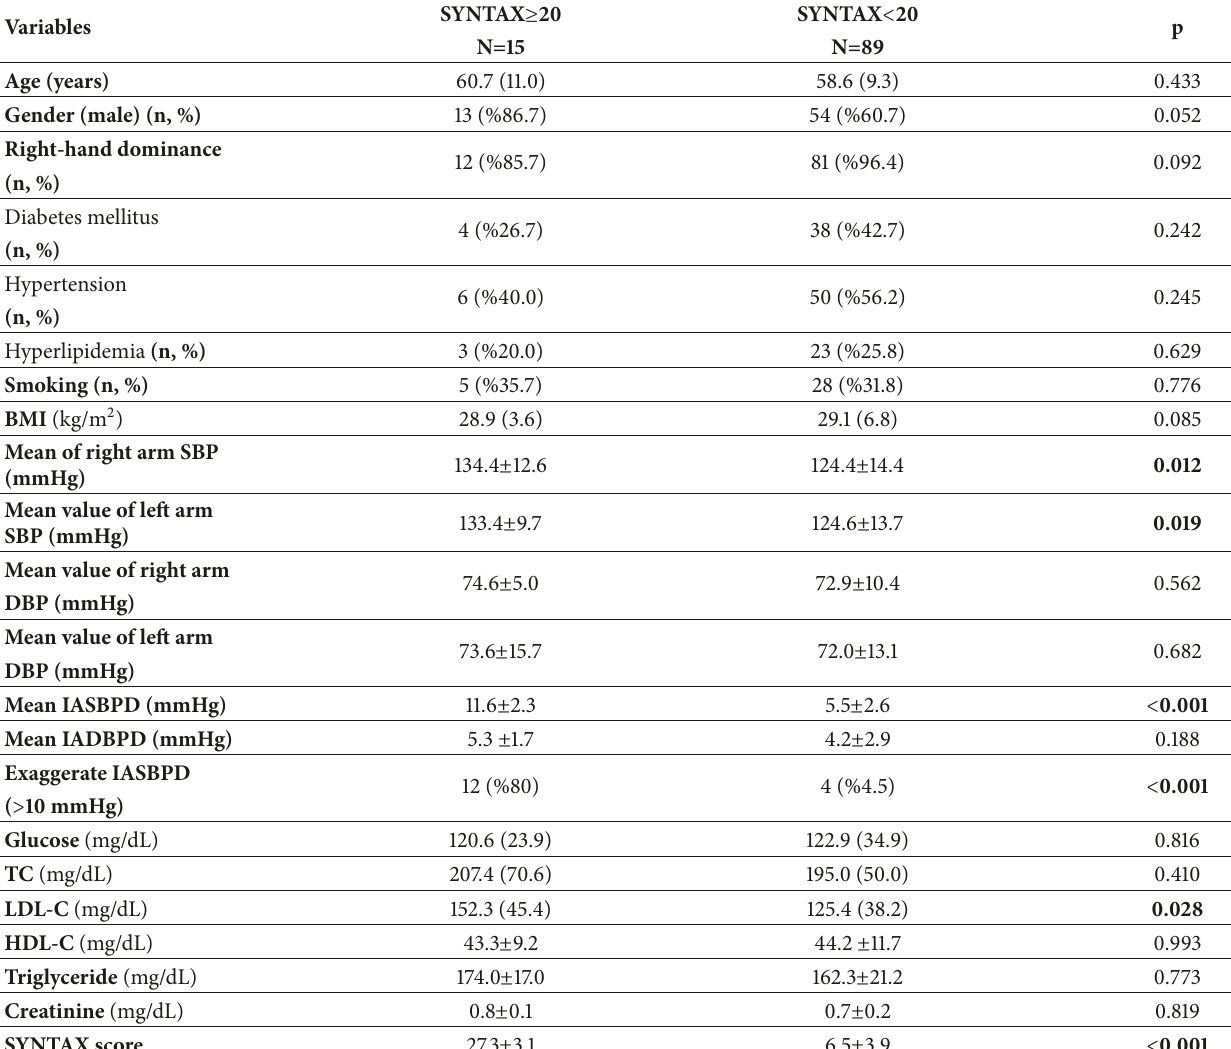
Table 1: Comparison of groups with high and low SYNTAX scores in terms of demographic and biochemical